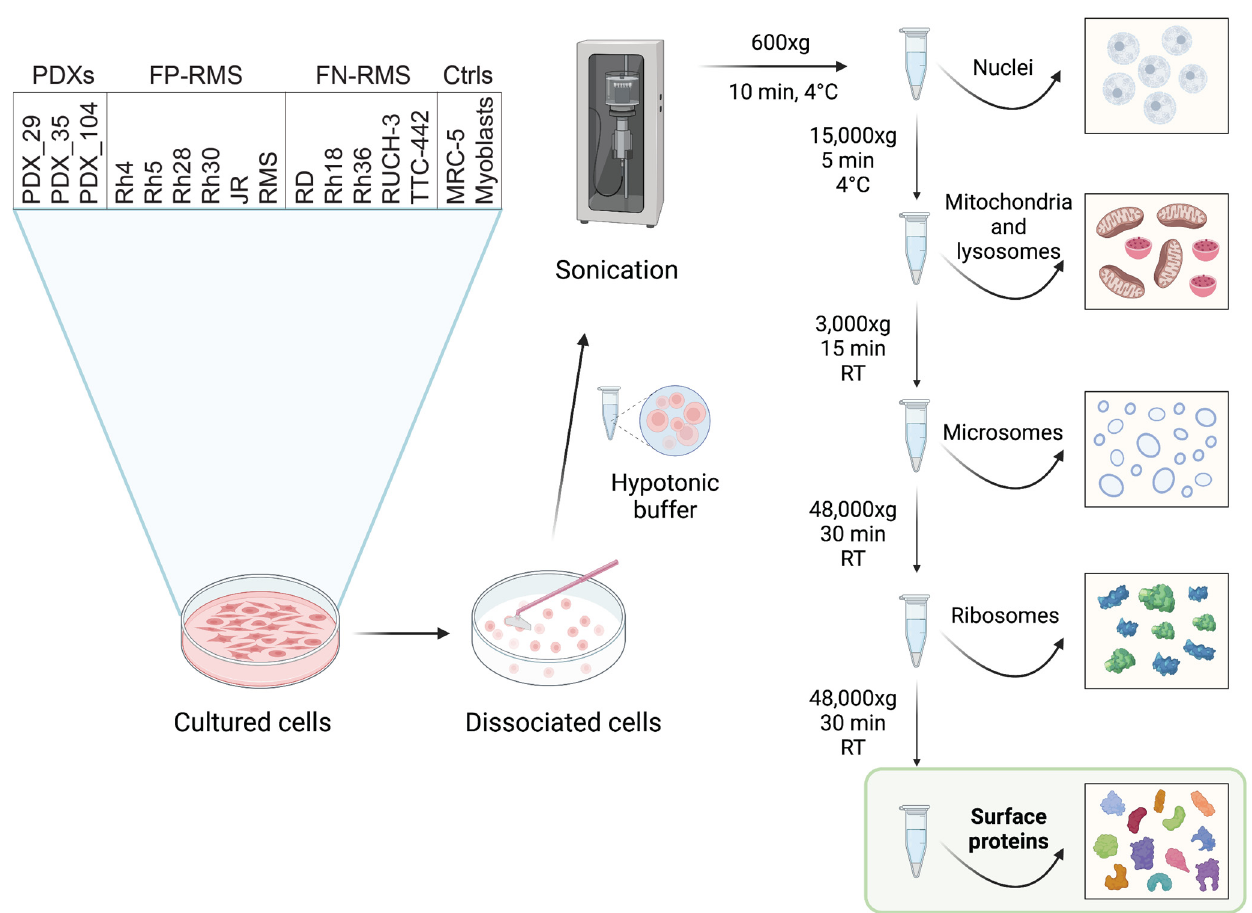
Figure 2. RMS cell lines and PDXs are used for differential centrifugation enrichment of membrane/surface proteins. RMS cell lines and PDXs, as well as the normal controls MRC-5 human embryonal fibroblasts and primary human myoblast, were cultured and used for the isolation of membrane/surface proteins. All experiments were performed in triplicates. Created with Biorender.com.